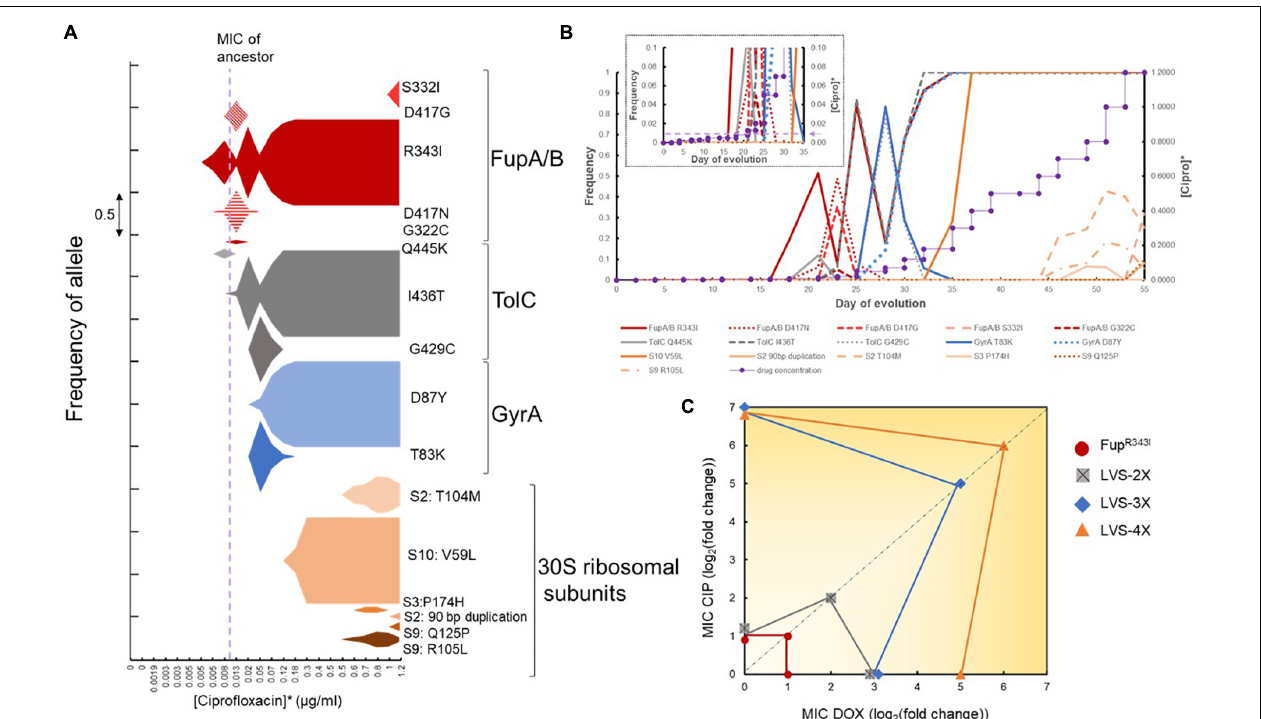
FIGURE 5 | Order of mutations acquired during combinatorial evolution to CIP and DOX. (A) Metagenomic analysis of a single population as it adapted to both doxycycline and ciprofloxacin simultaneously. The x-axis is the drug concentration used during adaptation while the area of the plots is the frequency of the specific allele. *Ciprofloxacin and doxycycline were applied simultaneously such that doxycycline concentration was eight times that of ciprofloxacin. The color shading corresponds to the general mutational class, e.g., red, FupA/B; gray, TolC; blue, GyrA; orange, 30S ribosomal proteins. It is clear from this figure that four mutant alleles, FupA/B R343I , TolC I436T , GyrA D87Y , and S10 V59L were the most successful in this population and reached saturation. These were the alleles selected to re-construct the mutations in the wild type strain in the order in which they arose in this population. (B) Line graph showing the frequency of mutant alleles (on primary Y-axis) arising in the same population shown in A plotted against the day of adaptation. The secondary Y-axis shows the step wise gradient of the drug concentration used during combinatorial selection (*Doxycycline concentration used = 8 times [Ciprofloxacin]). The inset shows a magnified version of the first 35 days of adaptation and the dotted line with the arrow shows the MIC of the wild type strain. (C) Mutational switch-backs shown as the accumulation of mutations during evolution. Resistance phenotypes of the engineered mutants that were created in the order in which the mutations appeared in the evolving population are shown. The X-axis represents the change in MIC of DOX, the Y-axis represents the change in MIC of CIP and the diagonal dotted line represents the change in MIC for the combination of CIP and DOX. Change in MIC is with reference to wild type LVS and is represented as log 2 (fold change). Noise has been added to overlapping data points on the X- and Y-axes to show